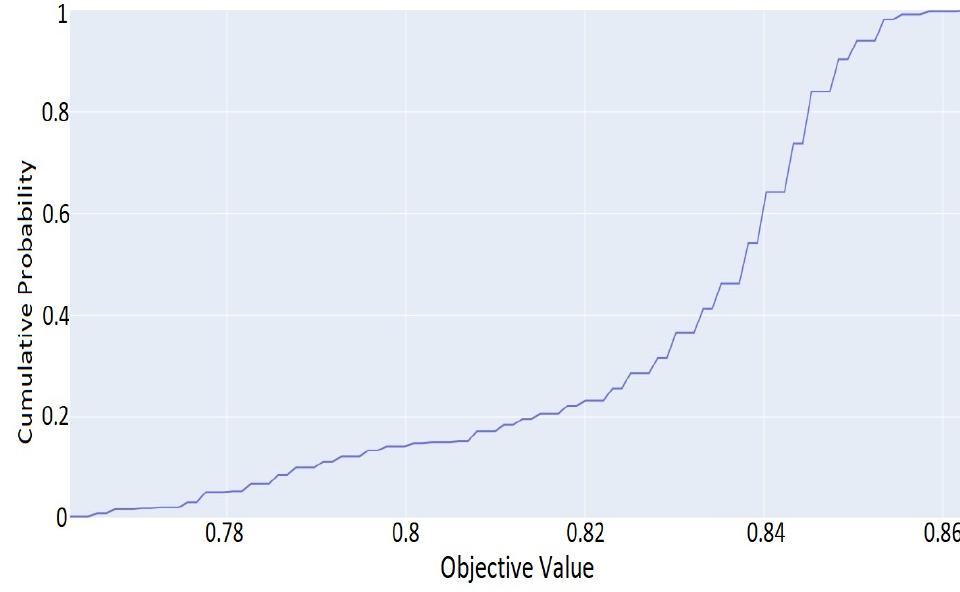
Figure 5. Cumulative probability distribution of the XGboost